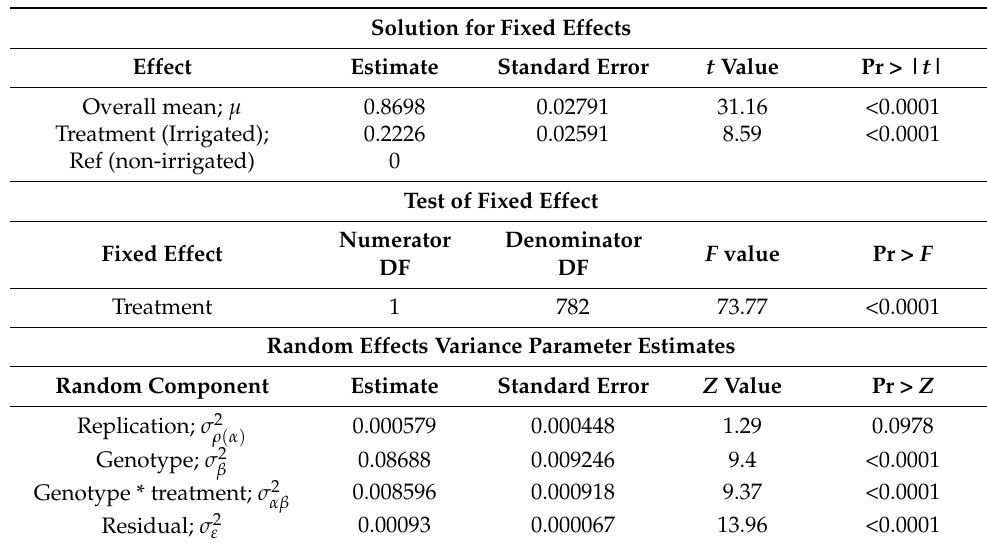
Table 5. Tests on fixed and random effects significance for grain